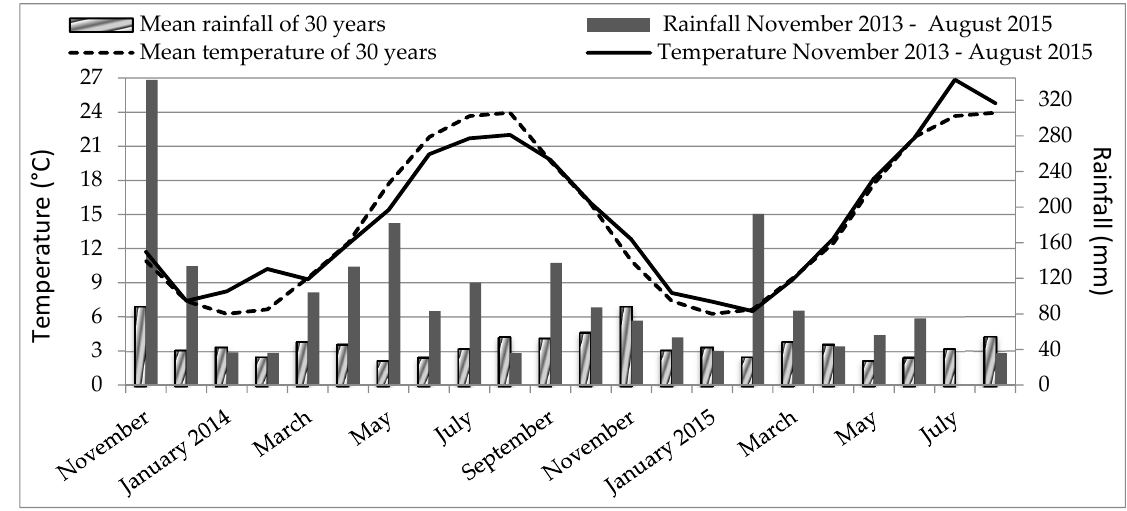
Figure 1. Mean monthly temperature and rainfall of the experimental trial during the barley and zucchini cycles compared with the mean long-term values (30 years).